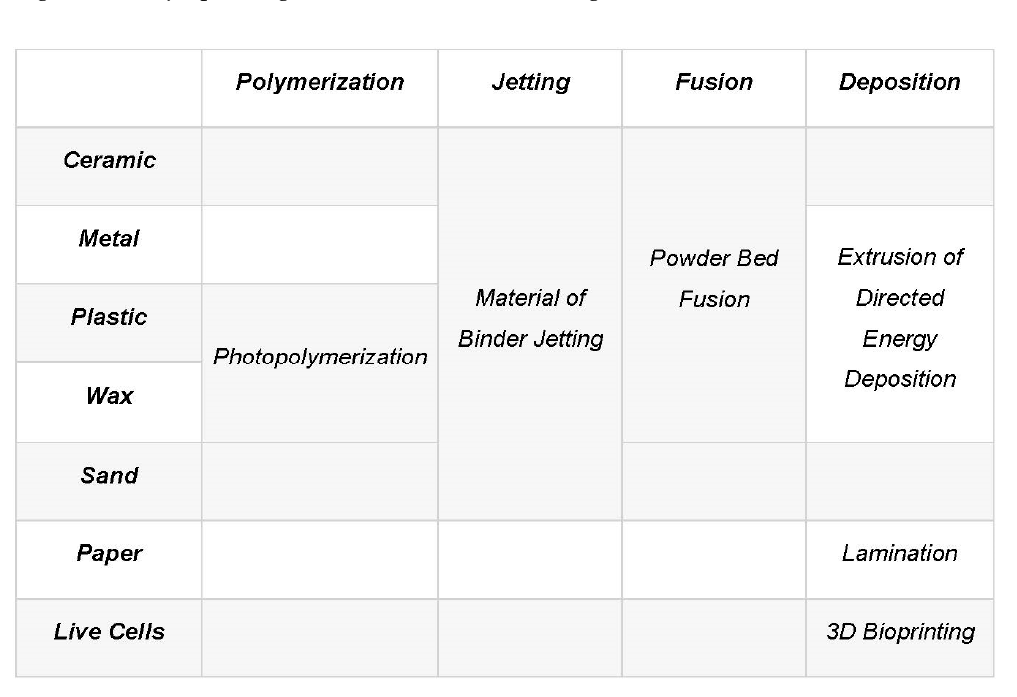
Figure 1. Infographic materials and 3D printing technology mapping [33–52,59–67].